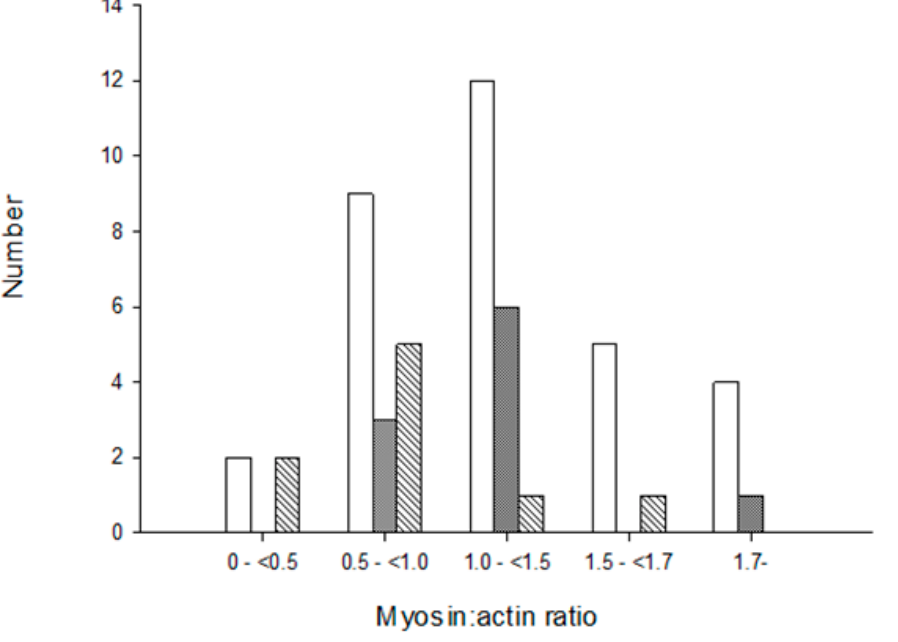
Figure 4. Diagnosis of critical illness myopathy (CIM) based on myosin loss determined from enzyme histochemical and immunocytochemically stained muscle biopsy cross-sections from ICU patients. Open bars represent no CIM, grey bars indicate suspect CIM and diagonal bars represent CIM. The myosin:actin ratios measured in biopsies from the same occasion and muscle are presented in a total of 51 patients in groups separated into severe (<0.5), high (0.5–<1.0), moderate (1.0–<1.5) to small (1.5– <1.7) preferential myosin loss as well as in patients with normal M:A ratios (>1.7).